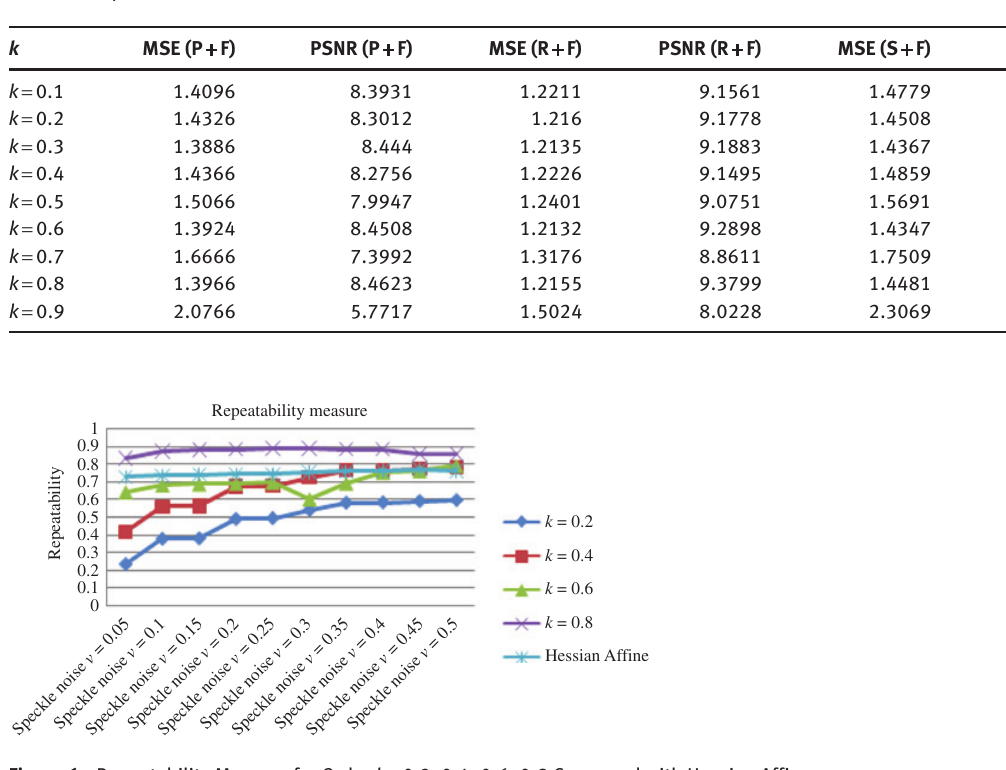
Table 2: MSE and PSNR of Prewitt with Fractional Operator (P + F), Robert with Fractional Operator (R + F), and Sobel with